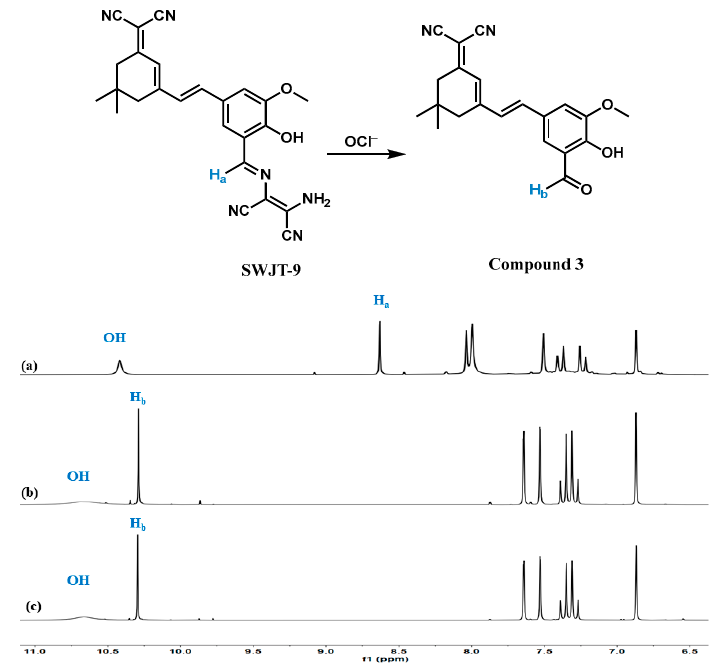
Figure 3. Partial 1 H NMR spectra of ( a ) SWJT-9 , ( b ) SWJT-9 + ClO − , and ( c ) compound 3 in DMSO- d 6 (400 MHz).